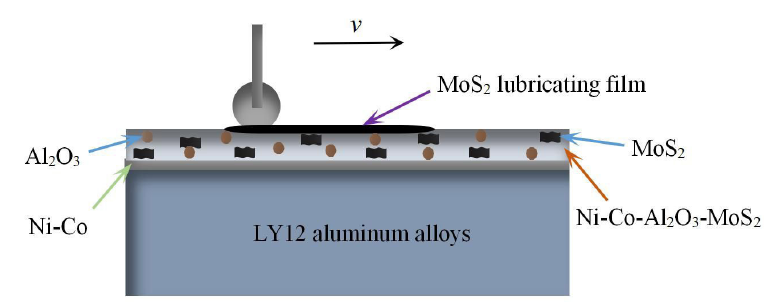
O -MoS composite coating prepared at 1.0 g·L -1 MoS 2 3 2